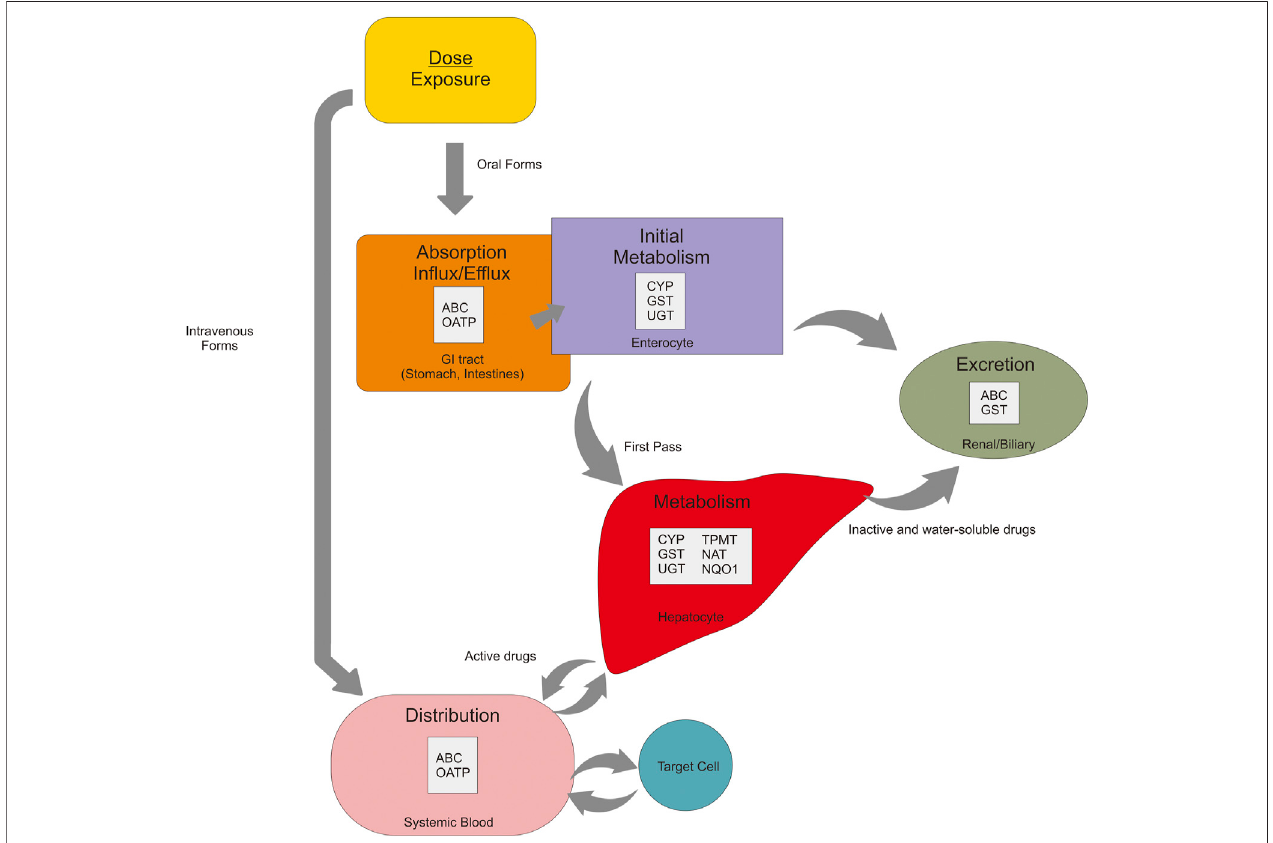
FIGURE 2 | Pharmacokinetics mechanisms of the oral drug are affected by many proteins in every pathway — absorption, metabolism, distribution, and excretion.